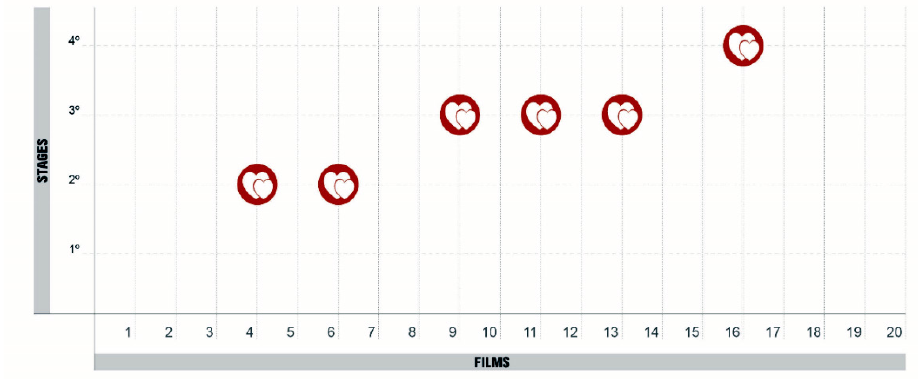
Figure 2. Characters indicator (passion and family): most representative films (source: created by